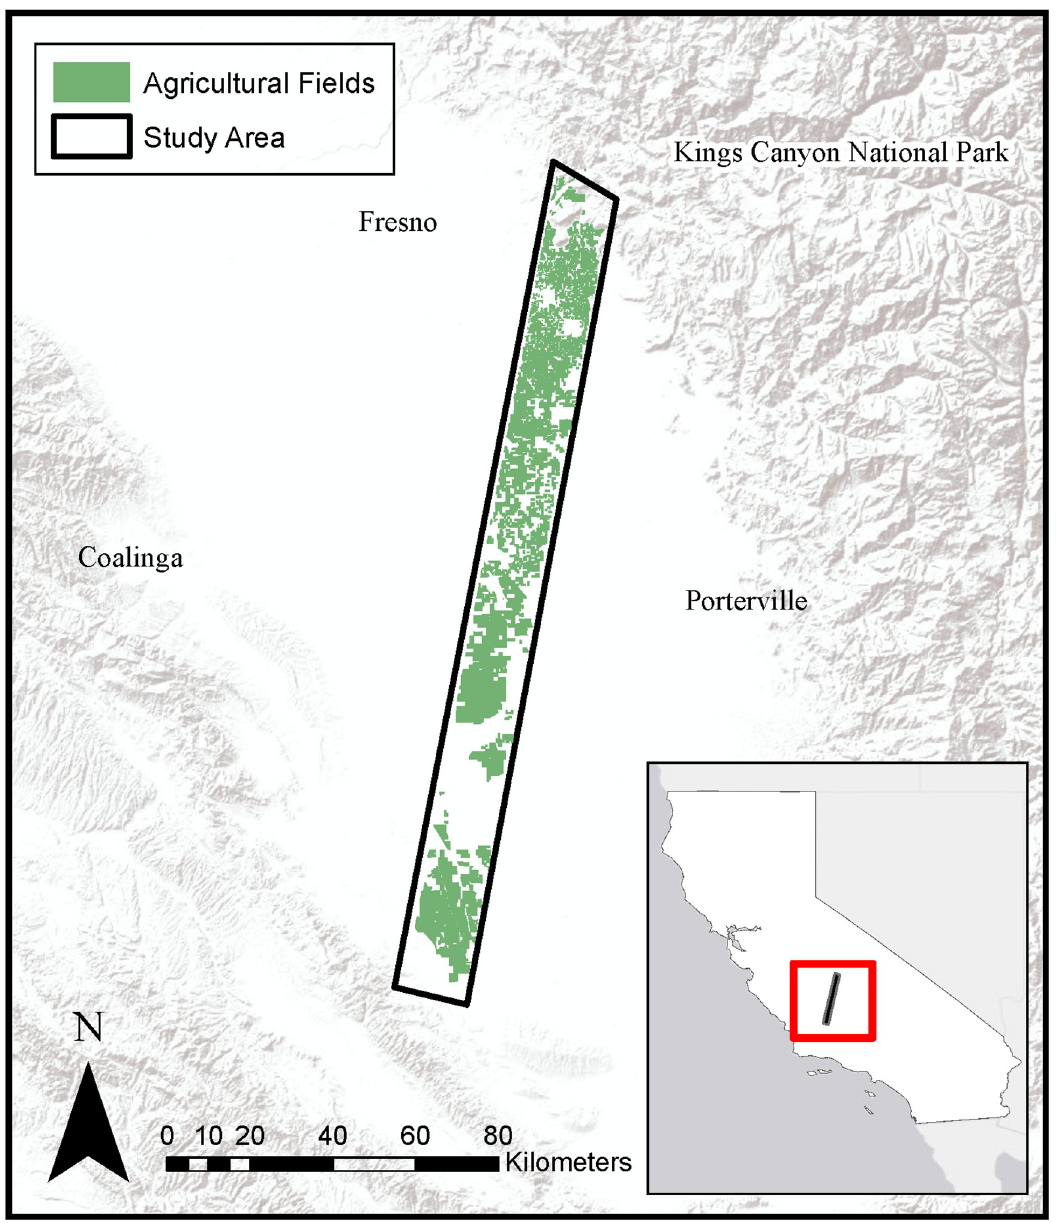
Fig 2. Study area within California’s Central Valley. Basemap obtained from Esri ArcGIS. Sources: Esri, DeLorme, HERE, MapmyIndia.